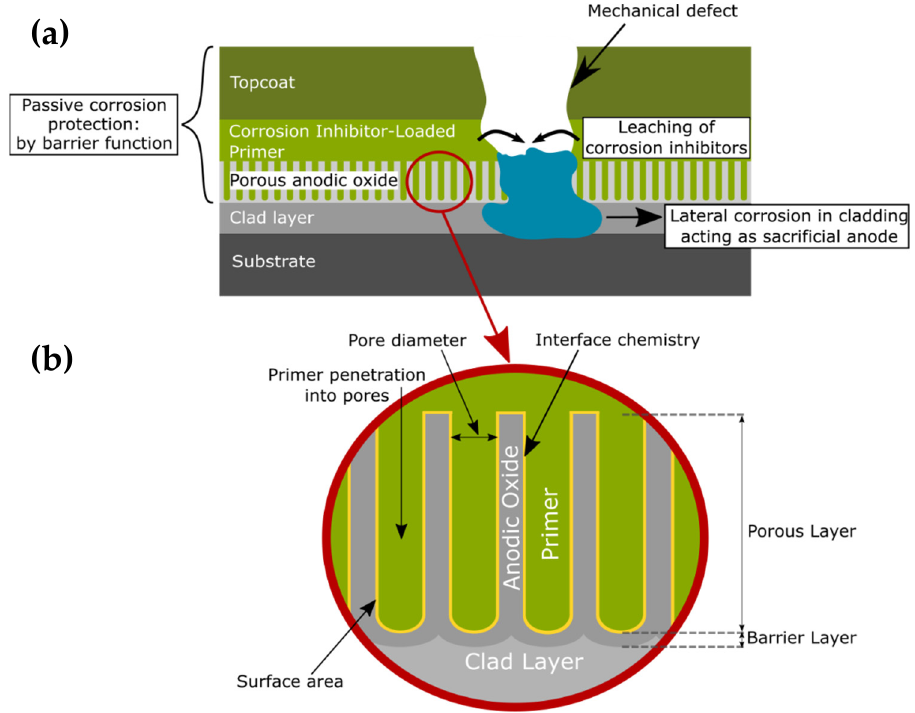
Figure 1. Schematic illustration of ( a ) typical corrosion protection scheme in aerospace applications and ( b ) important features of corrosion protective anodic oxide films. Reprinted with permission from [15] .